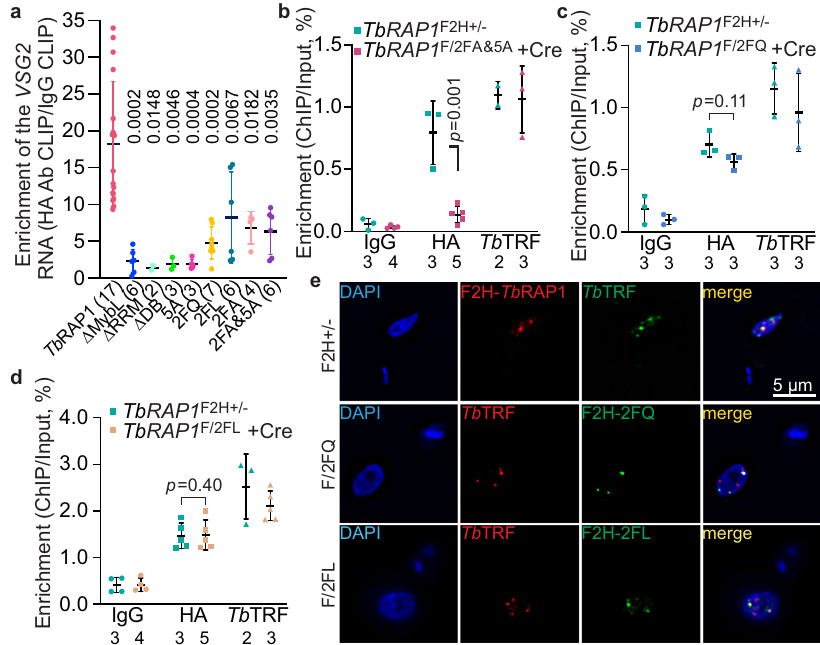
Fig. 4 | Tb RAP1 interacts with the active VSG RNA through its RRM domain in vivo. a RNA CLIP experiments were performed in various TbRAP1 F/mut strains (expressing VSG2) after a 30-h induction of Cre. The presence of the active VSG2 RNAintheRNACLIPproductwasdeterminedbyqRT-PCR.Theenrichmentof VSG2 RNA (CLIP/Input) was calculated for the CLIP experiment using the HA antibody 12CA5andthatusingIgG.Relativeenrichmentwascalculatedusingtheenrichment of IgG CLIP as a reference. Average and standard deviation were calculated from two toseventeenindependentexperiments(theexactnumberofexperiments was indicated in parentheses following each strain name). P values of two-sided unpaired t -tests between the TbRAP1 F2H+/- and TbRAP1 F/mut are shown on top of correspondingcolumns.DataforWT Tb RAP1isthesameasthatinFig.1a. b – d ChIP